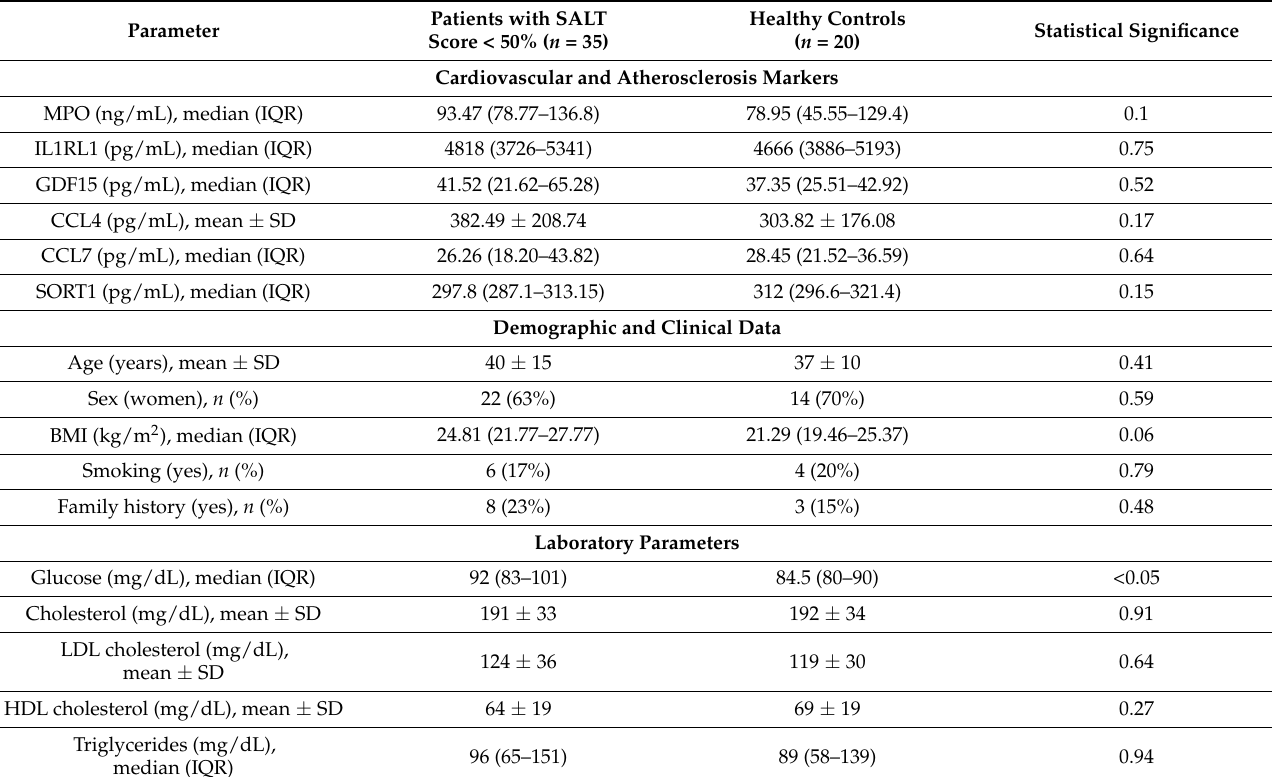
Table 3. Baseline characteristics and assessment of cardiovascular and atherosclerosis markers in patients with alopecia areata compared to healthy controls.